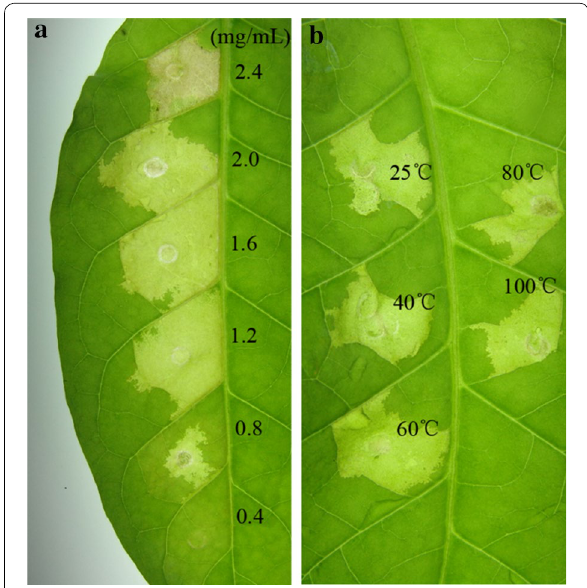
Fig. 3 The characterization of AMEP412 for its HR activity. a The minimum concentration of AMEP412 for its HR activity. Serial dilutions of AMEP412 (2.4, 2.0, 1.6, 1.2, 0.8 and 0.4 mg mL − 1 ) were infiltrated into tobacco leaves, and HR was observed after 24 h. b The thermal stability of AMEP412 for its HR activity. AMEP412 was treated at different temperatures (25, 40, 60, 80 and 100 °C) for 5 min, infiltrated into leaves and photographed at 24